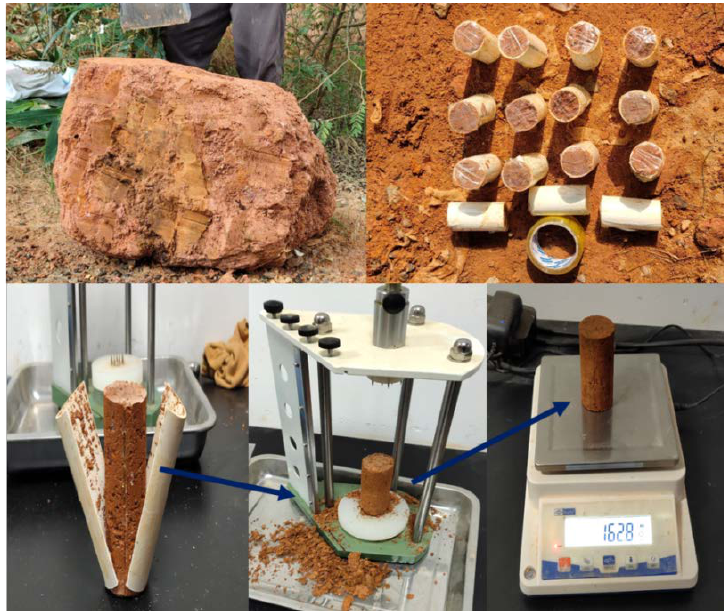
Figure 3. Trimming of the intact samples. Table 1. Testing conditions of the isotropic compression path of the intact